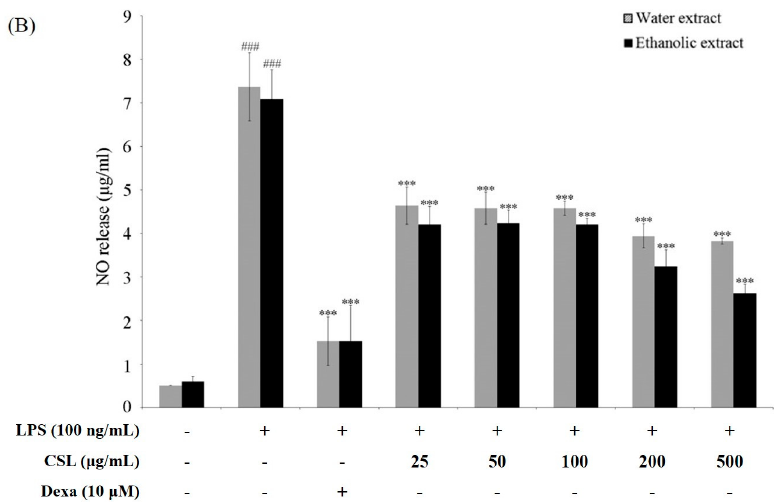
Figure 1. Cell viability and inhibition of nitrite production ( A ) RAW 264.7 cells were pretreated with extracts of CSL for 1 h (at 25, 50, 100, 200, 500 µ g/mL), and then treated with LPS (100 ng/mL) for 18 h. Cell viability was measured with the MTT assay. Data are represented as mean ± SD ( n = 4) with a one-way ANOVA followed by the Dunnett’s test. * p < 0.05, ** p < 0.01 and *** p < 0.001 vs. control; ( B ) RAW 264.7 cells were pretreated for 1 h with extracts of CSL and then treated with LPS (100 ng/mL) for 18 h. The concentration of NO in the culture medium was determined by using the Griess assay. Data are represented as mean ± SD ( n = 4) with a one-way ANOVA followed by the Dunnett’s test. ### p < 0.001 vs. control, *** p < 0.001 vs. LPS. 2.5. Inhibition of LPS-Induced Proinflammatory Cytokine Production by CSLE in LPS-Stimulated RAW 264.7 Cells